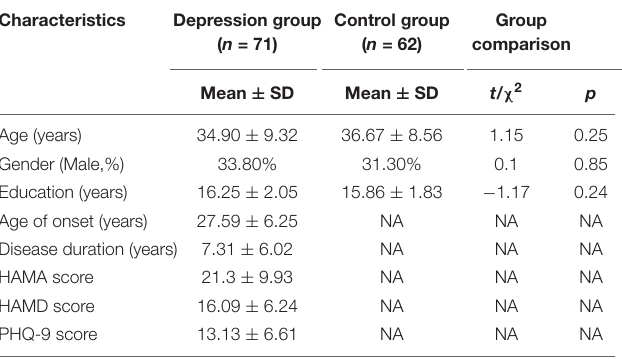
TABLE 1 | Demographic and clinical characteristics of all participants N = 133.